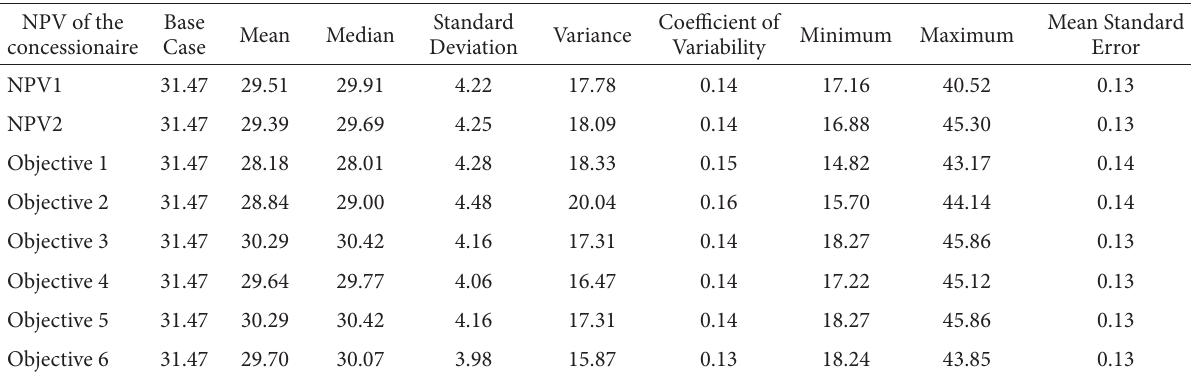
Table 5. Comparisons of the total NPV under different cases (in million Eur) NPV of the Base Mean Median concessionaire Case